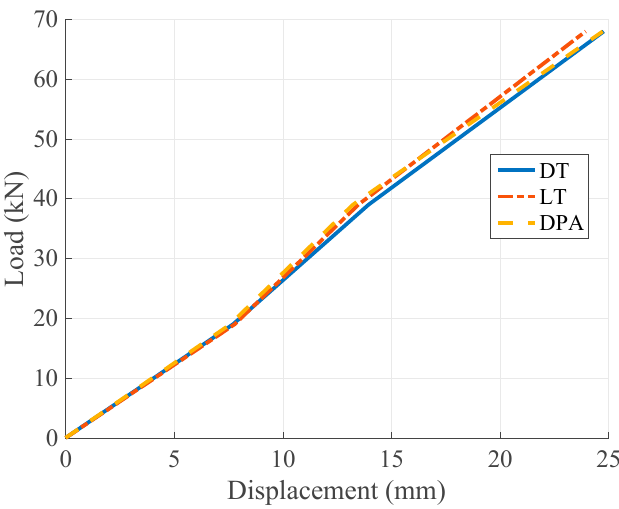
Figure 10. Displacements comparison for beam#1 LC2.